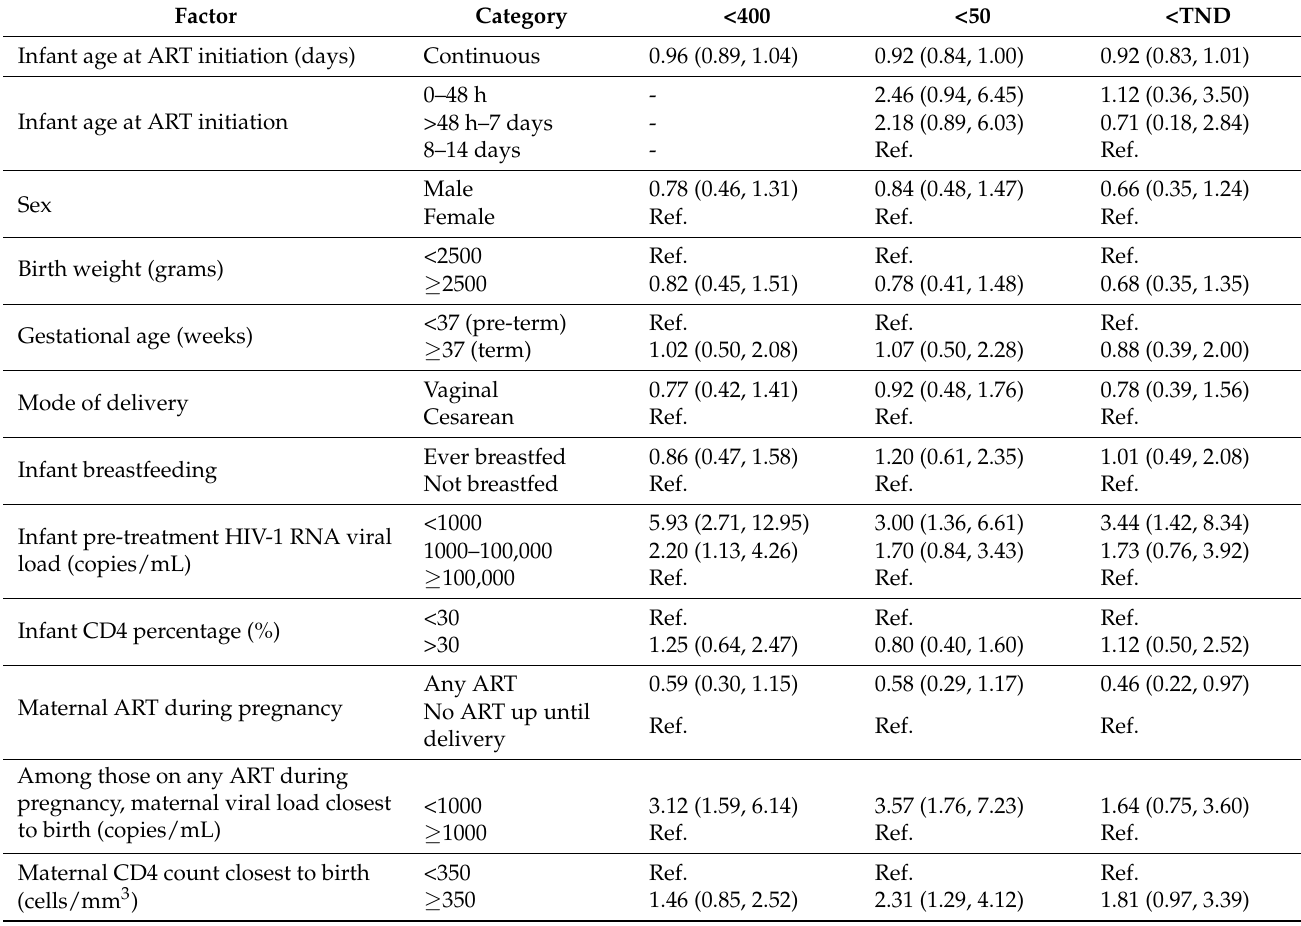
Table 3. Factors associated with time to any HIV-1 RNA viral load <400 copies/mL, <50 copies/mL, or target not detected (TND) by 72 weeks; presented are hazard ratios (HR) from Cox proportional hazards regression models; HR >1.0 indicates parameter is protective and reflects “better viral suppression”.